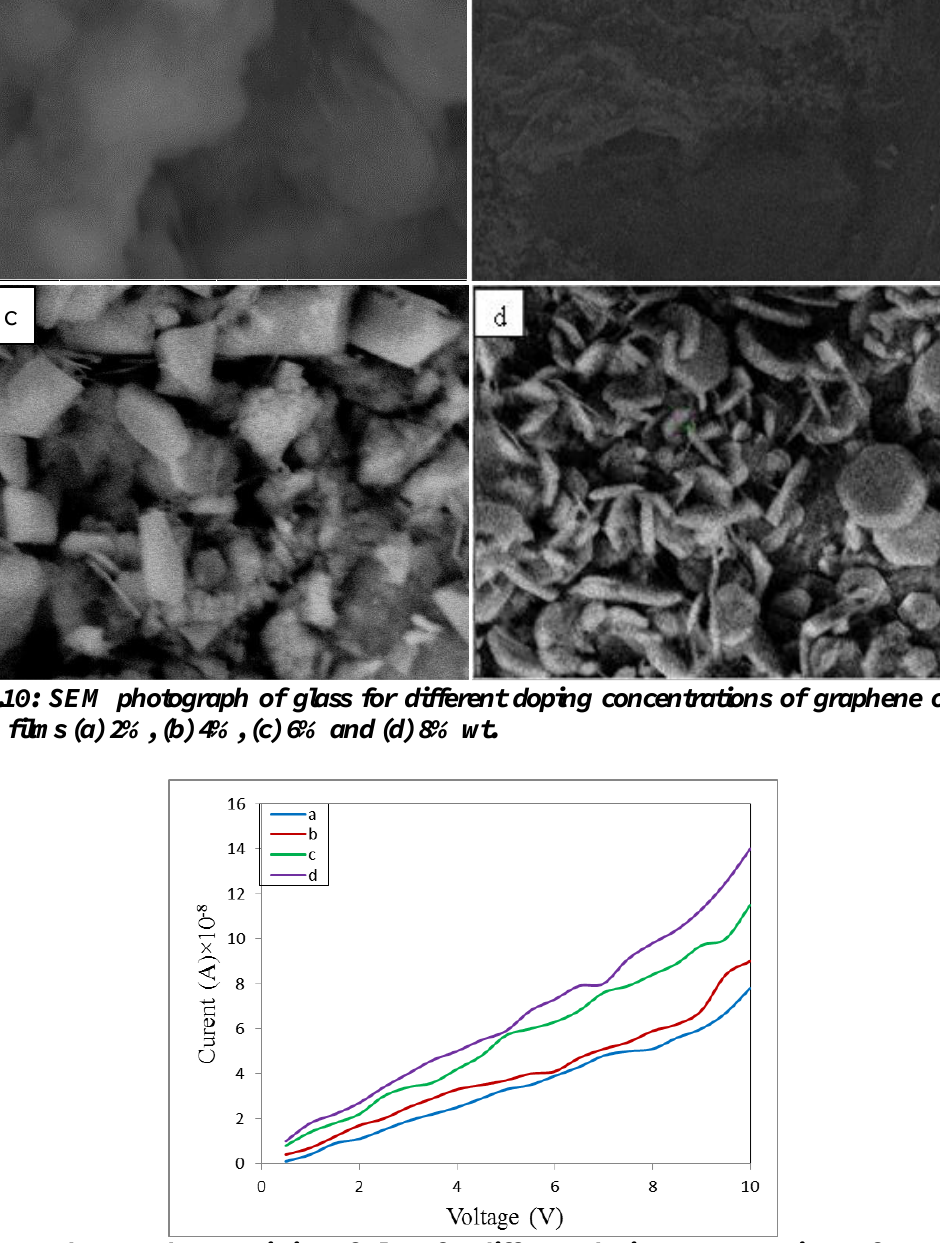
Fig.11: The I-V characteristics of glass for different doping concentrations of graphene oxide thin films ((a) 2%, (b) 4%, (c) 6%, (d) 8% wt).